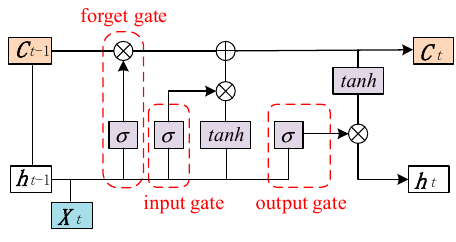
Figure 3. Architecture of